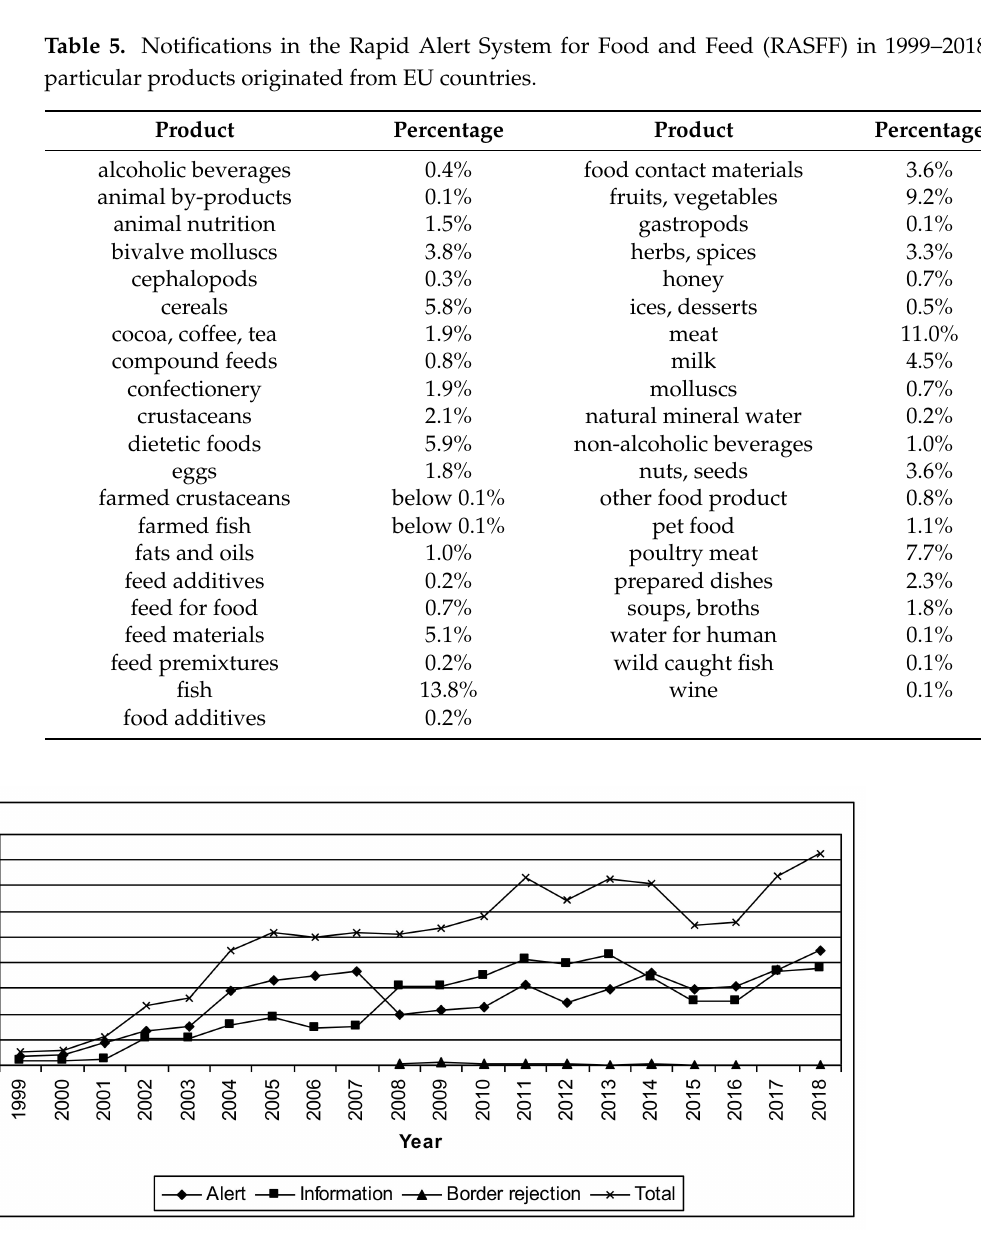
Figure 2. Number of notifications on food originated from EU countries in 1999–2018 according to the